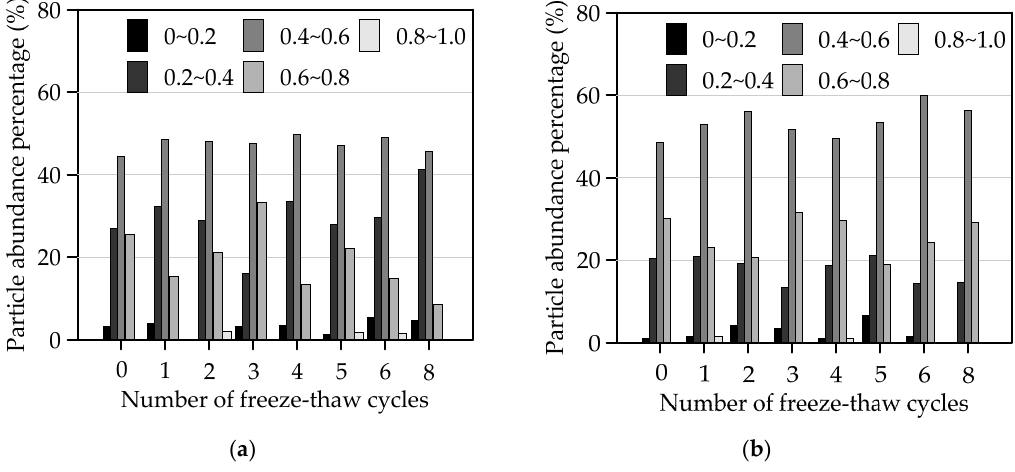
Figure 6. Particle abundance percentage under F-T cycles: (a) S0 and (b) S2. Table 4. C under F-T